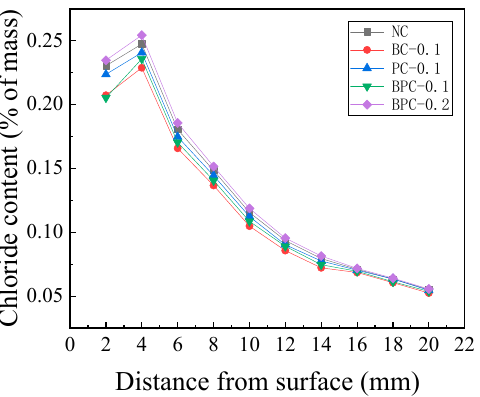
Figure 4. Chloride content distribution of the HBPRC after 30 days drying–wetting cycles.